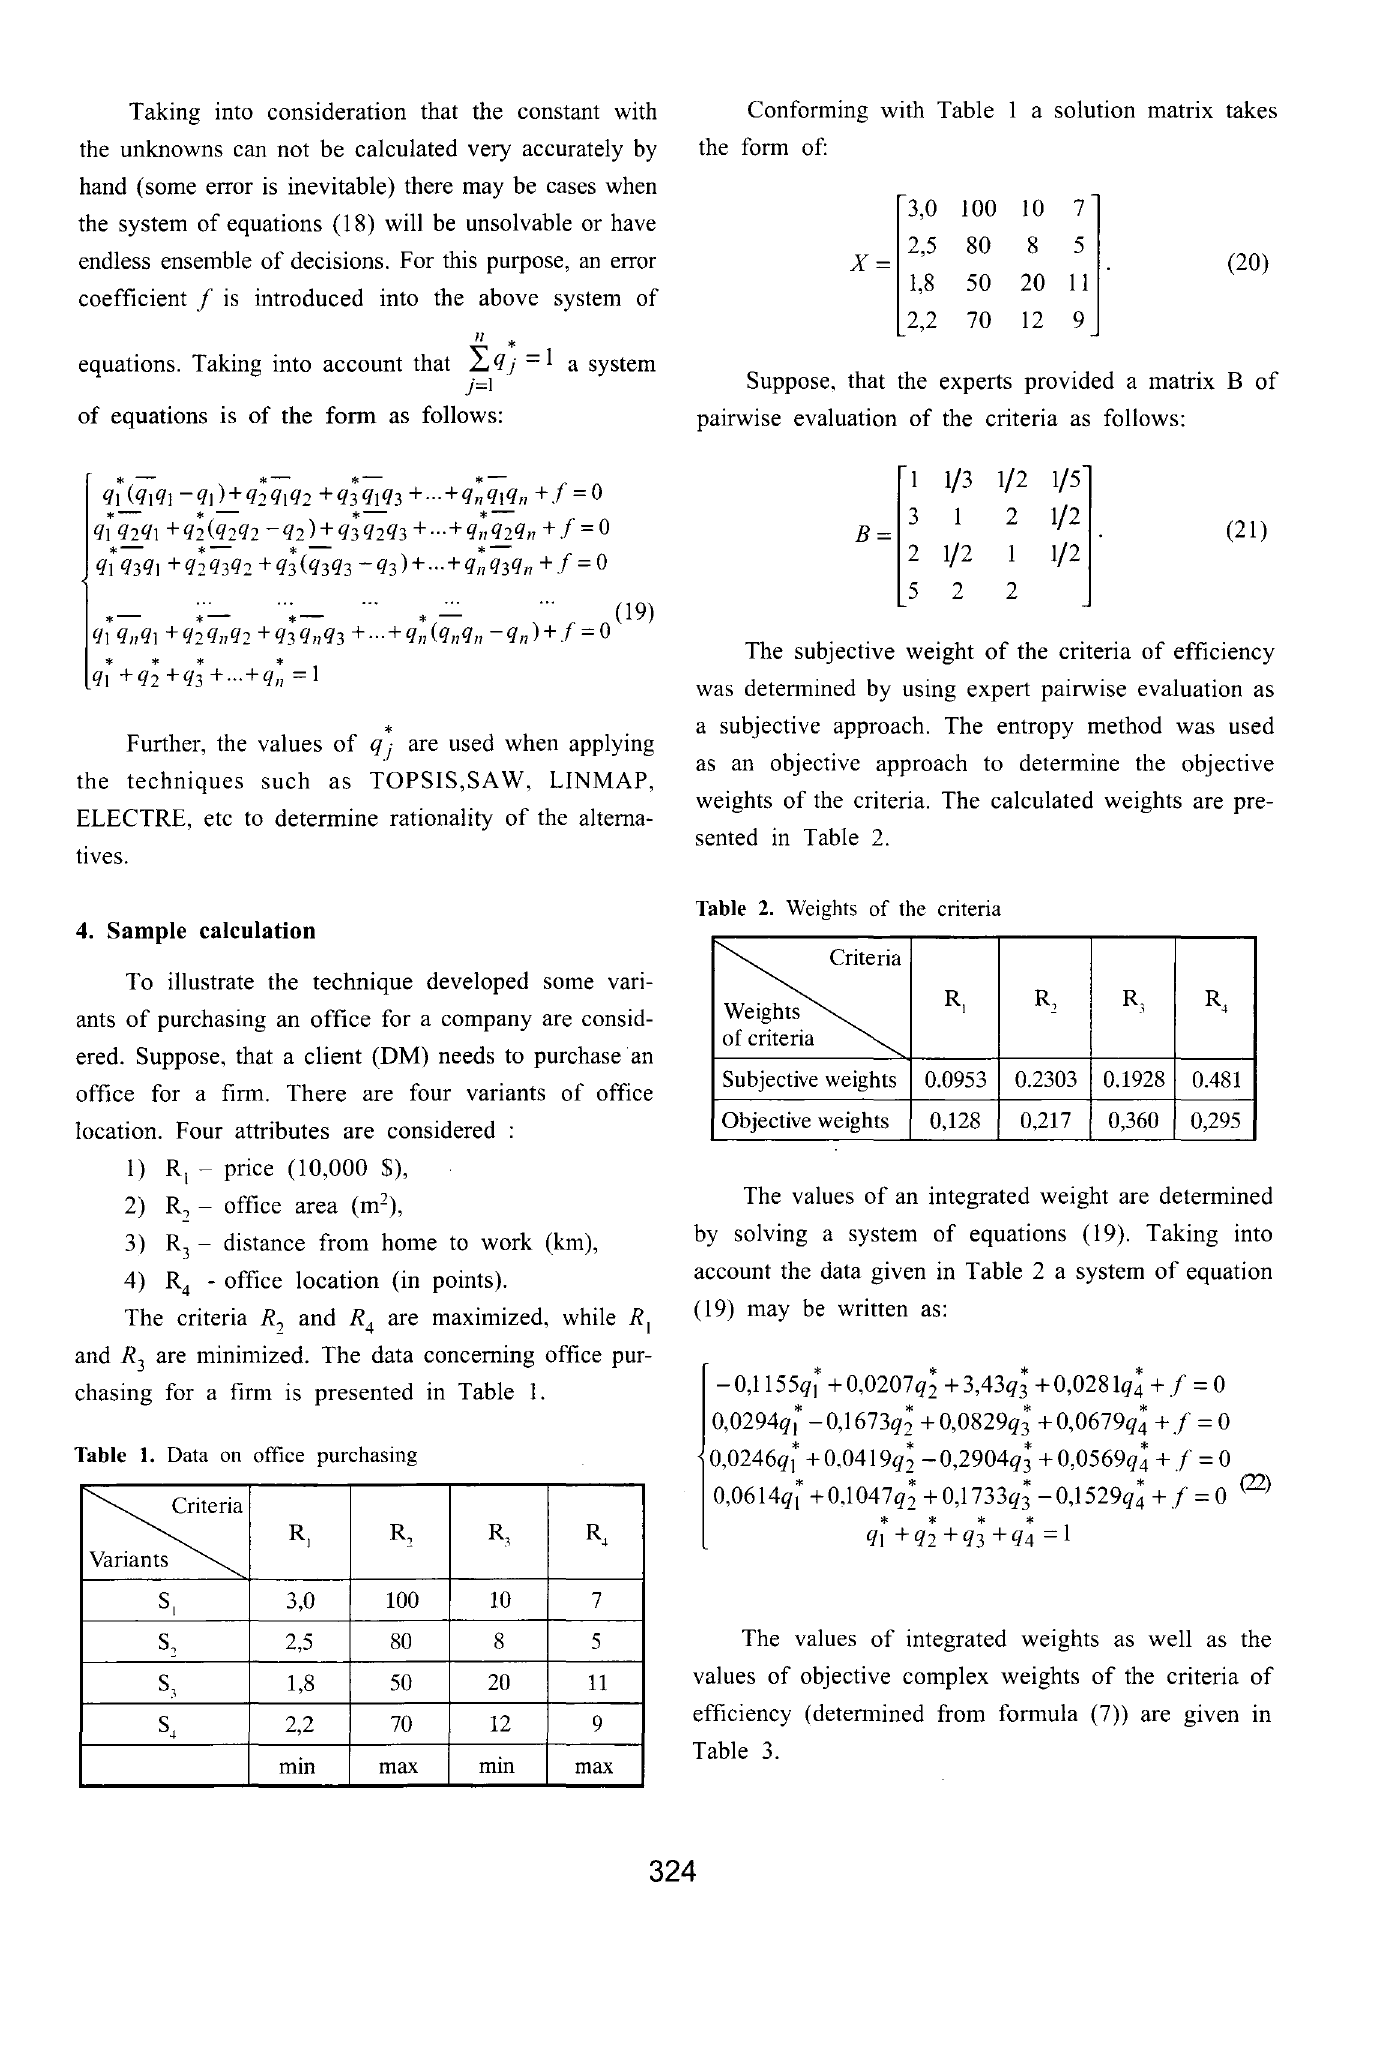
Table 2. Weights of the